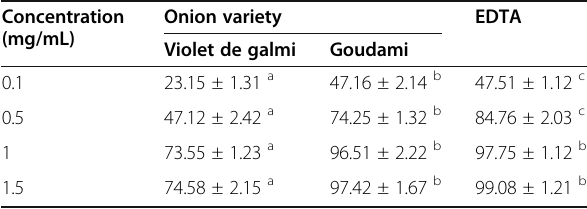
Table 5 Chelating Power of aqueous extracts of onions with standard EDTA